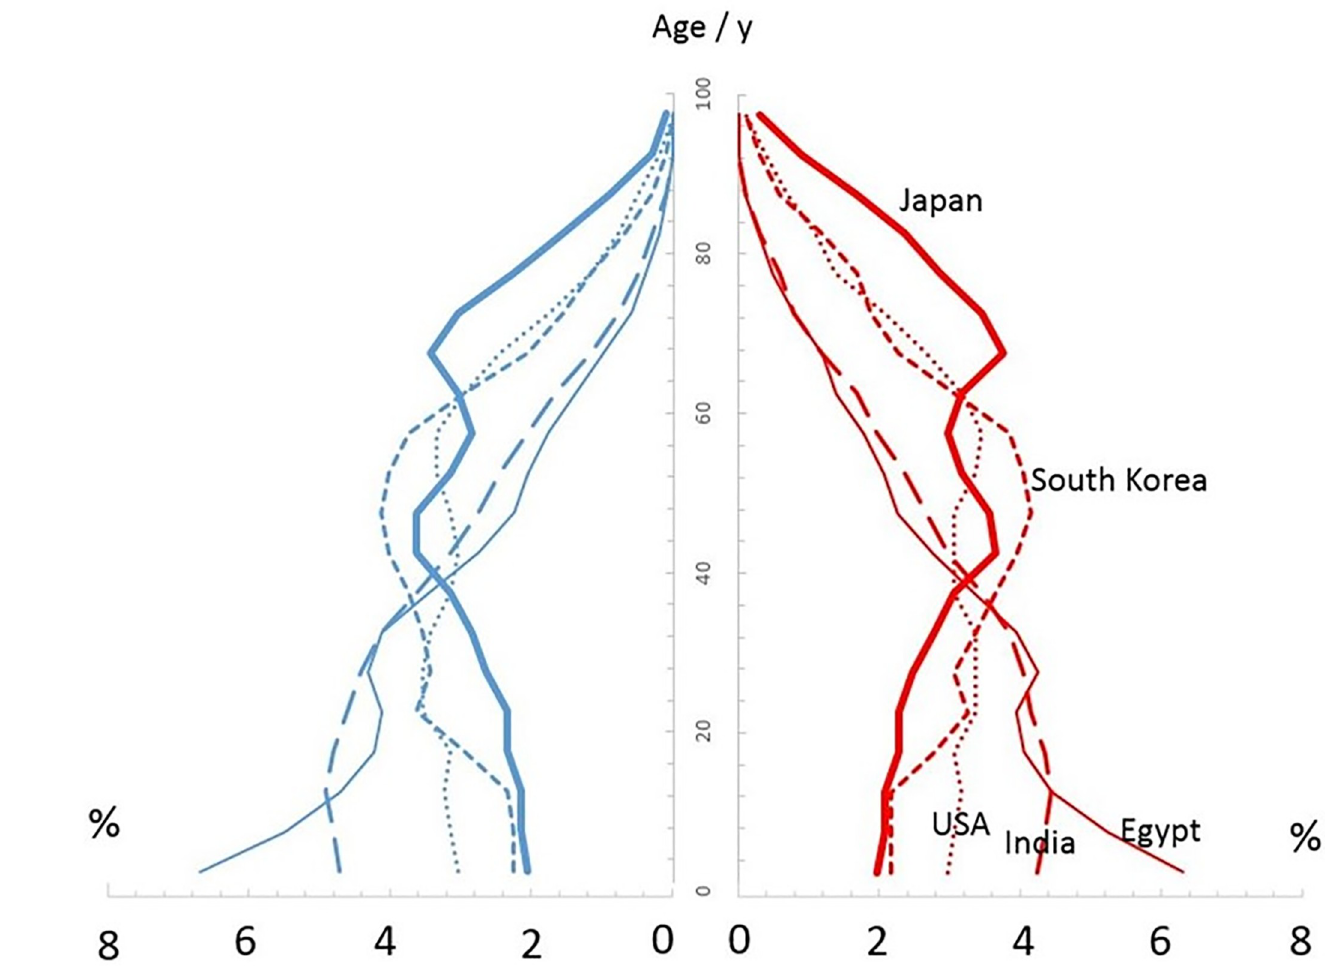
Fig 2. Example of age distributions, ADW(age) , taken from UN estimates of Egypt, India, Japan, South Korea, and the United States. Age distribution taken from United Nations (2015).